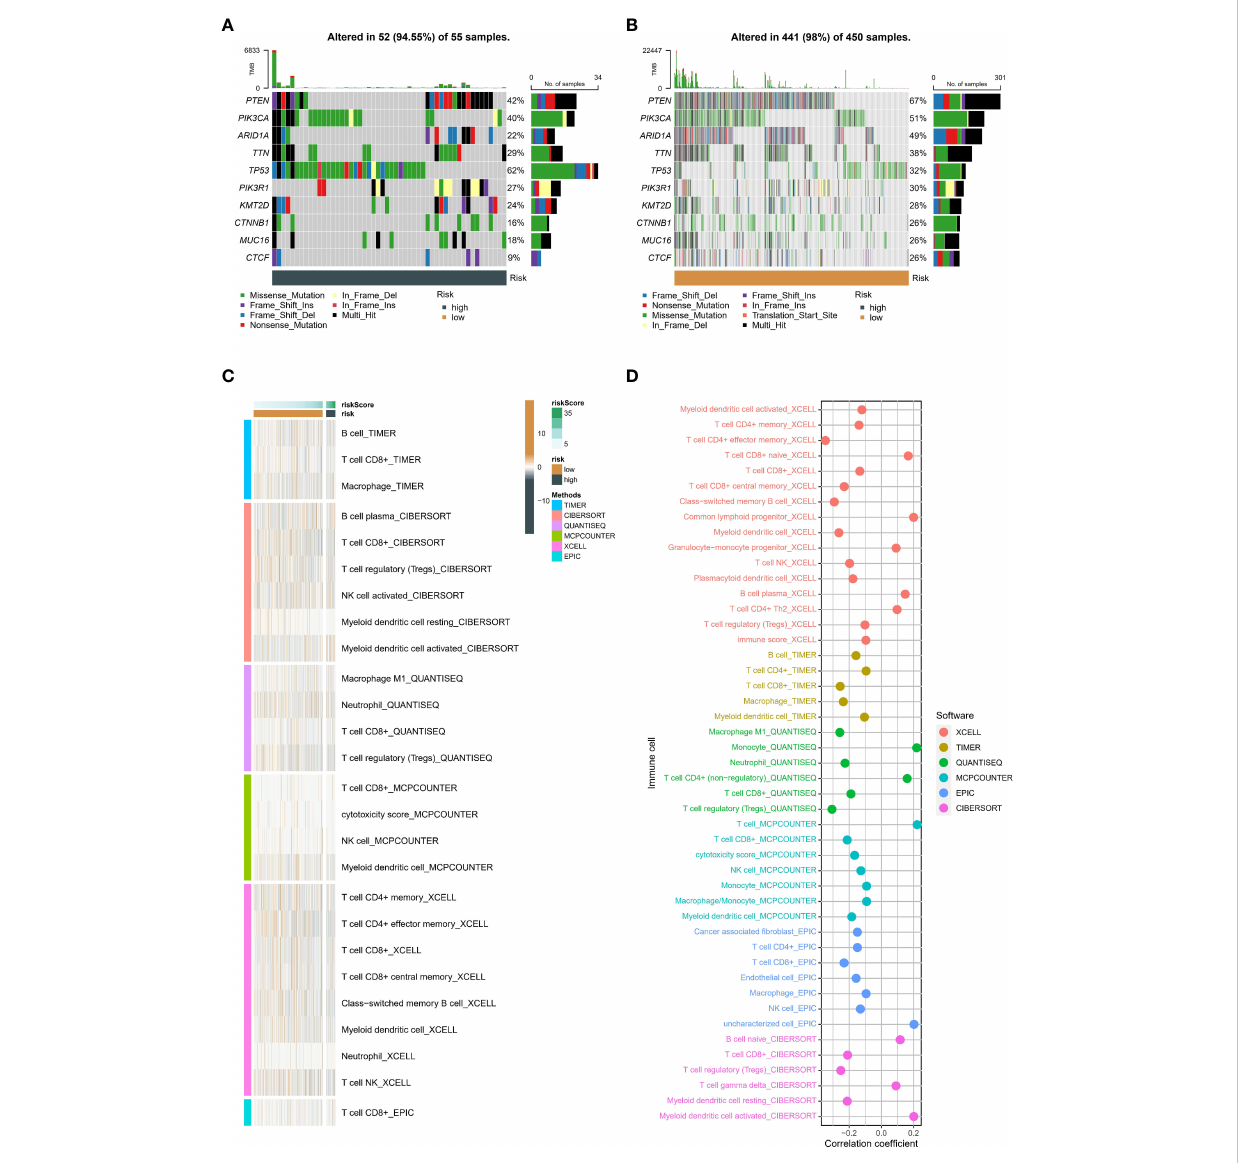
FIGURE 8 Genetic variants and tumor microenvironment in different risk. (A) The top 10 mutated genes in the high-risk group. (B) The top 10 mutated genes in the low-risk group. (C) Difference of abundance of immune cells based on six algorithm in different risk groups. (D) Correlation between abundance of immune cells based on six algorithm and risk